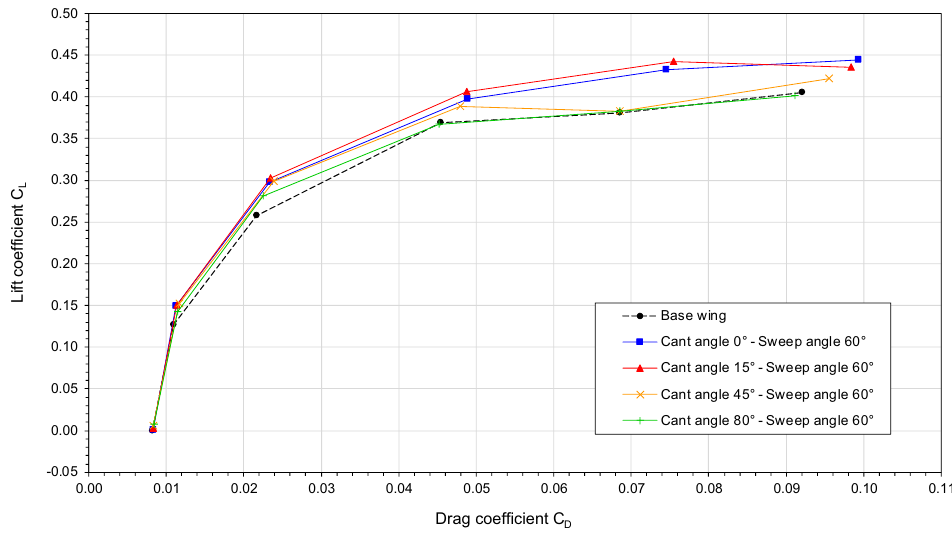
Figure 13. Drag polar at Mach number 0.8395, winglet sweep angle 60 ◦ and different values of cant angle.